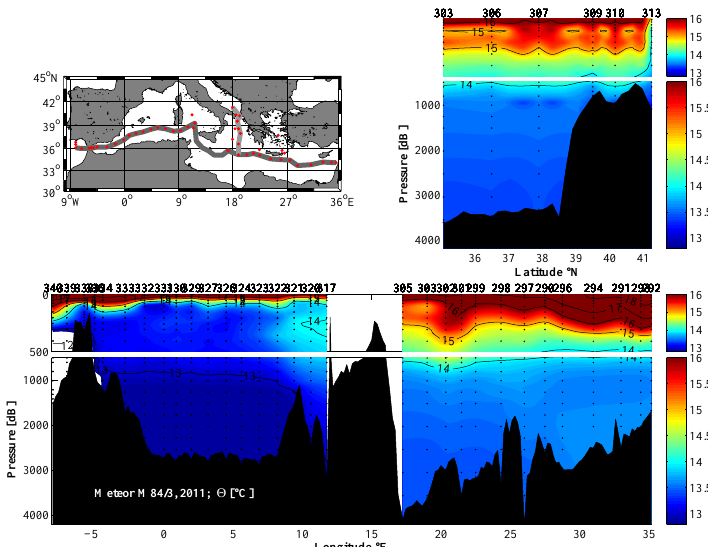
Fig. 4. Similar to Fig. 3, but for potential temperature.